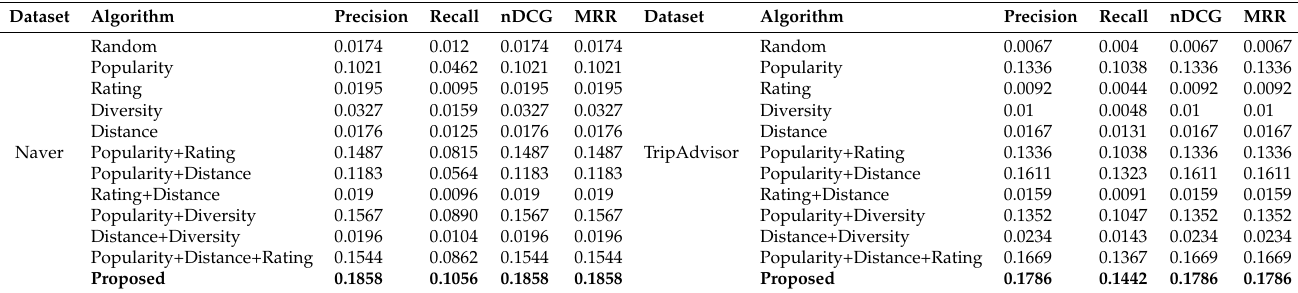
Figure 8. Accuracy comparisons. Table 5. Top 1 recommendation accuracy